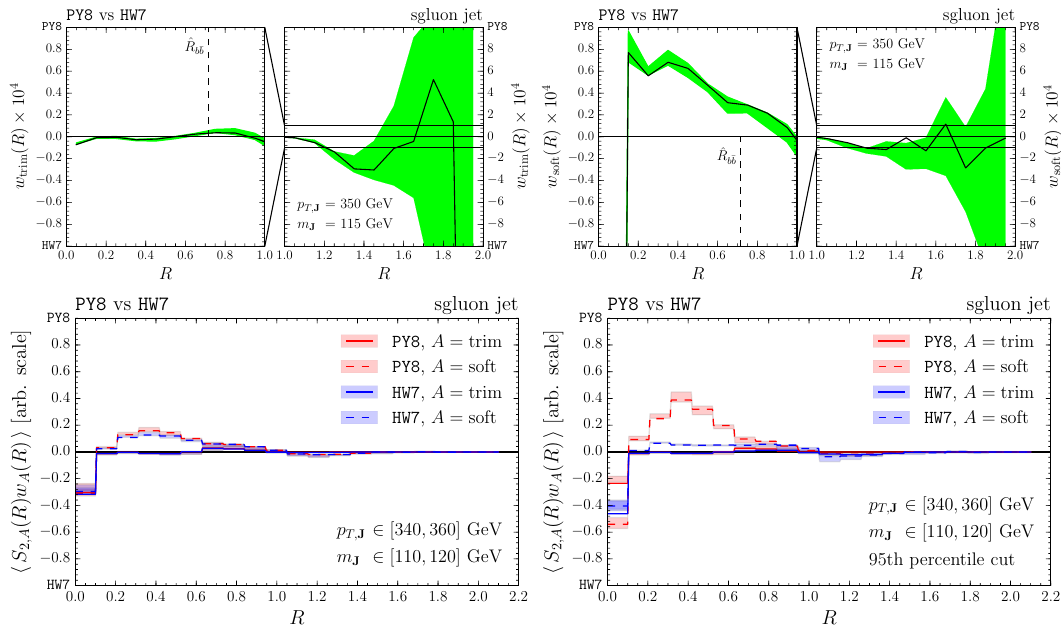
Figure 18 . Top (cid:12)gures are the weights w trim (left) and w soft (right) at p T; J = 350 GeV and m J = 115 GeV for classifying sgluon jet of PY8 and HW7 events. Bottom (cid:12)gures are In the right bottom (cid:12)gure, we additionally demand that ^ y 1 of the PY8 generated jets and ^ y 2 of the HW7 generated jets are larger than their 95th percentile respectively. We show their statistical uncertainty from the training samples as colored